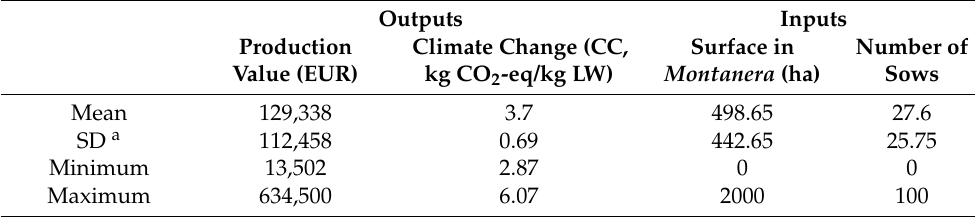
Table 3. Variables used in the data envelopment analysis (DEA) model ( n =